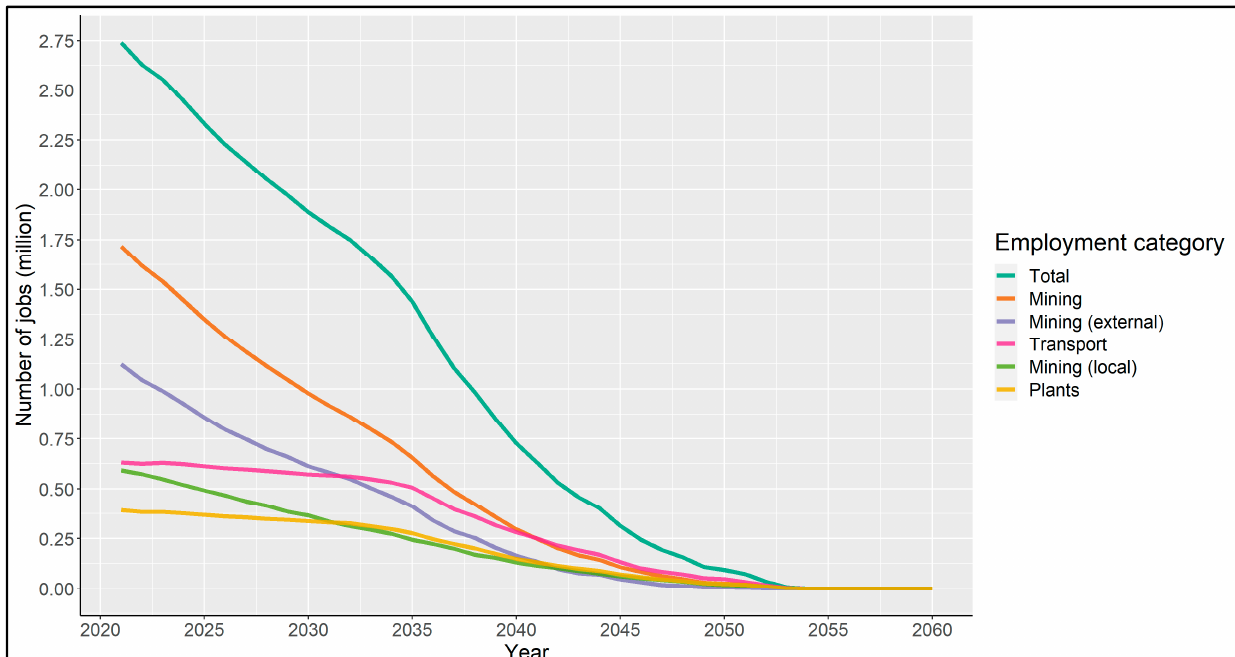
Figure 4. Employment in coal plants, transport and mines, 2021–2060, baseline scenario.